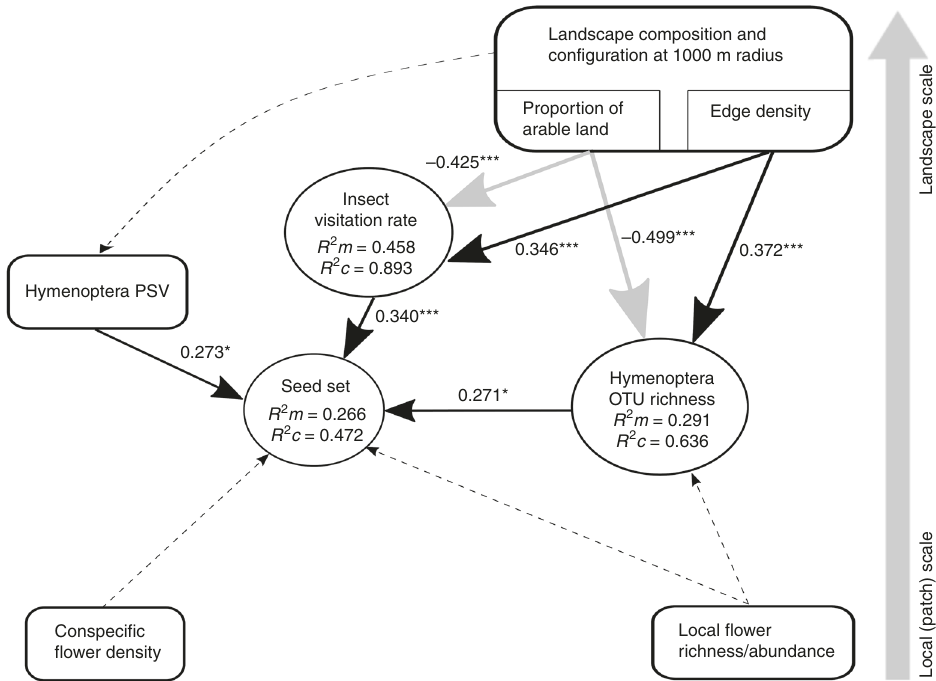
Fig. 7 Disentangling key drivers of Trifolium pratense seed set across rural and urban ecosystems. Final path model of the direct and indirect effects of fl ower visitation rate, pollinator diversity, local patch and landscape factors on T. pratense pollination in combined rural and urban sites ( N = 18 sites). Black arrows show positive and grey arrows show negative effects derived from SEM analysis whilst dashed arrows show hypothesized effects. Arrow thickness corresponds to the size of path coef fi cients. Standardized path coef fi cients are reported next to the bold arrows and R 2 values (conditional R 2 c as well as marginal R 2 m ) are reported for all response variables within boxes; GLMM and LMM: one star, P < 0.05; three stars, P < 0.001. PSV, phylogenetic species variability. Factors potentially affecting pollination have been separated vertically by the scale at which they likely operate (local-patch to landscape scale) for